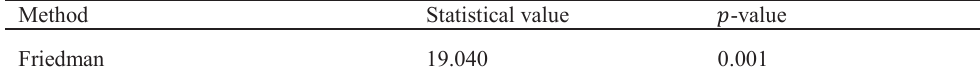
Table 17. Results of Friedman’s test based on the average best-so-far for unimodal test functions of set 2.